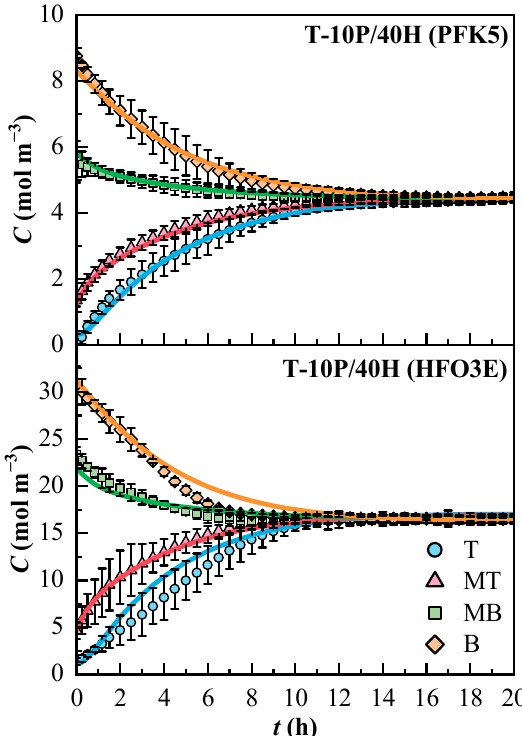
Figure 5. Experimental ( C exp, dots) and estimated ( C model , solid lines) concentration profiles of the components of the ternary mixture over time. T (Top, ), MT (Medium Top, (cid:52) ), MB (Medium (cid:35) Bottom, (cid:3) ), and B (Bottom, ) correspond to the different heights of the measurement lines. (cid:51)